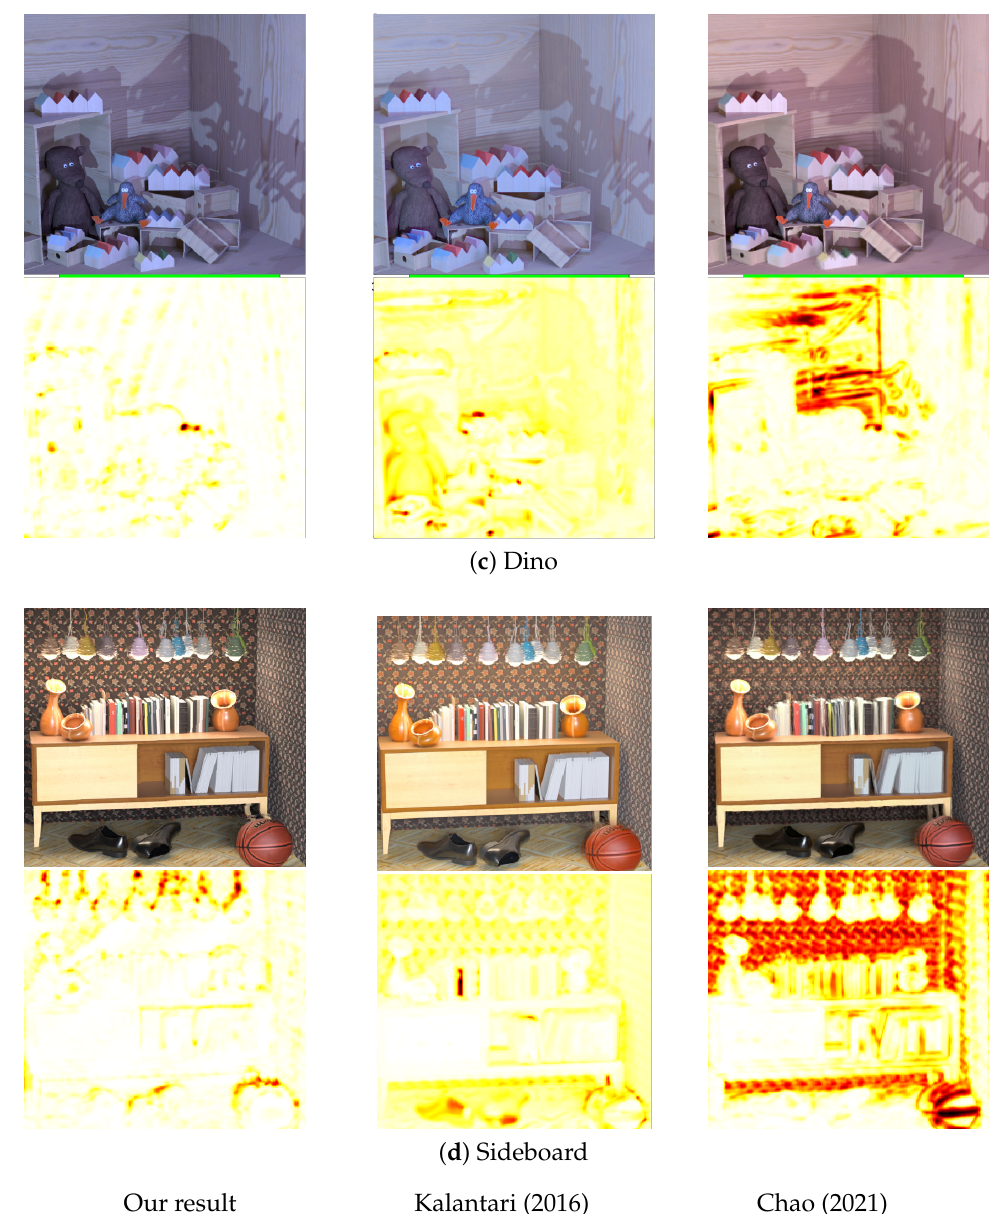
Figure 12. Visual comparison for the ’Boxes’, ’Cotton’, ’Dino’ and ’Sideboard’ image synthesized top left sub-aperture view and the SSIM with the ground-truth sub-aperture view for the proposed algorithm, Kalantari et al. [21] and Chao et al.